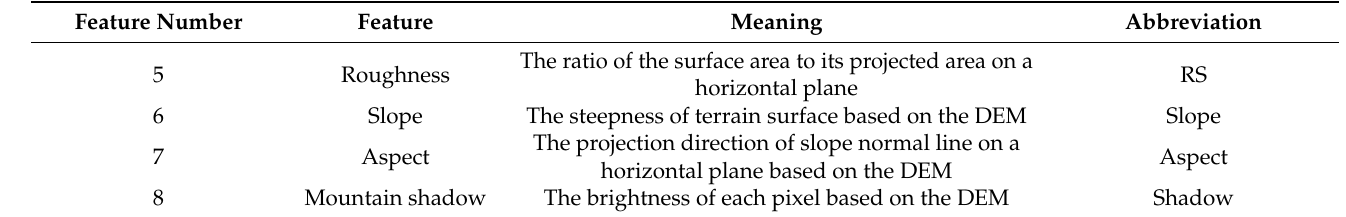
Table 5. Terrain